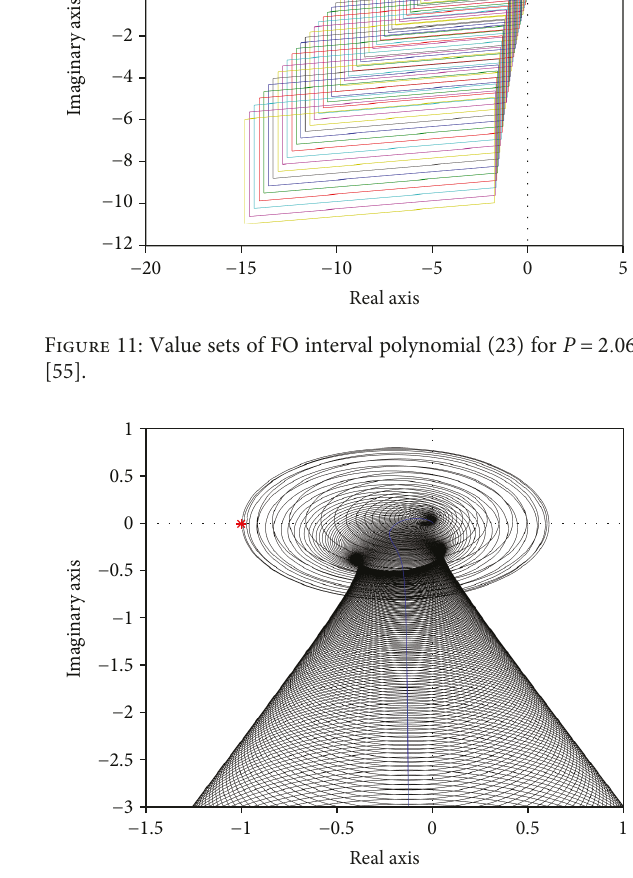
Figure 12: Envelope of Nyquist diagrams for FO plant family (27) and controller P = 1 18